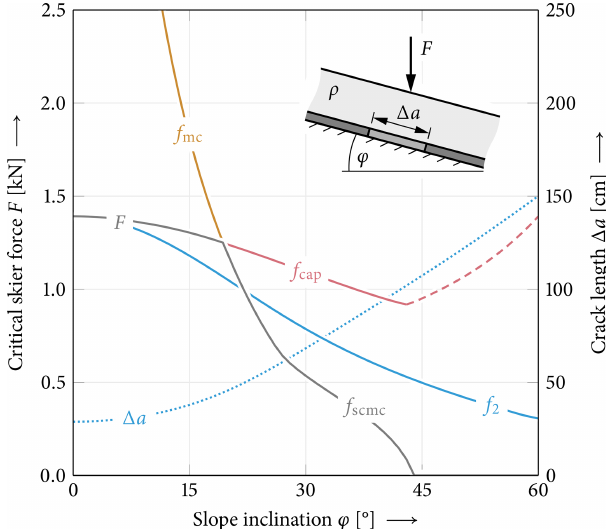
Figure 8. Comparison of mixed-mode energy criteria for a defect- free snowpack loaded by a point load and the weight of the slab above the weak layer.